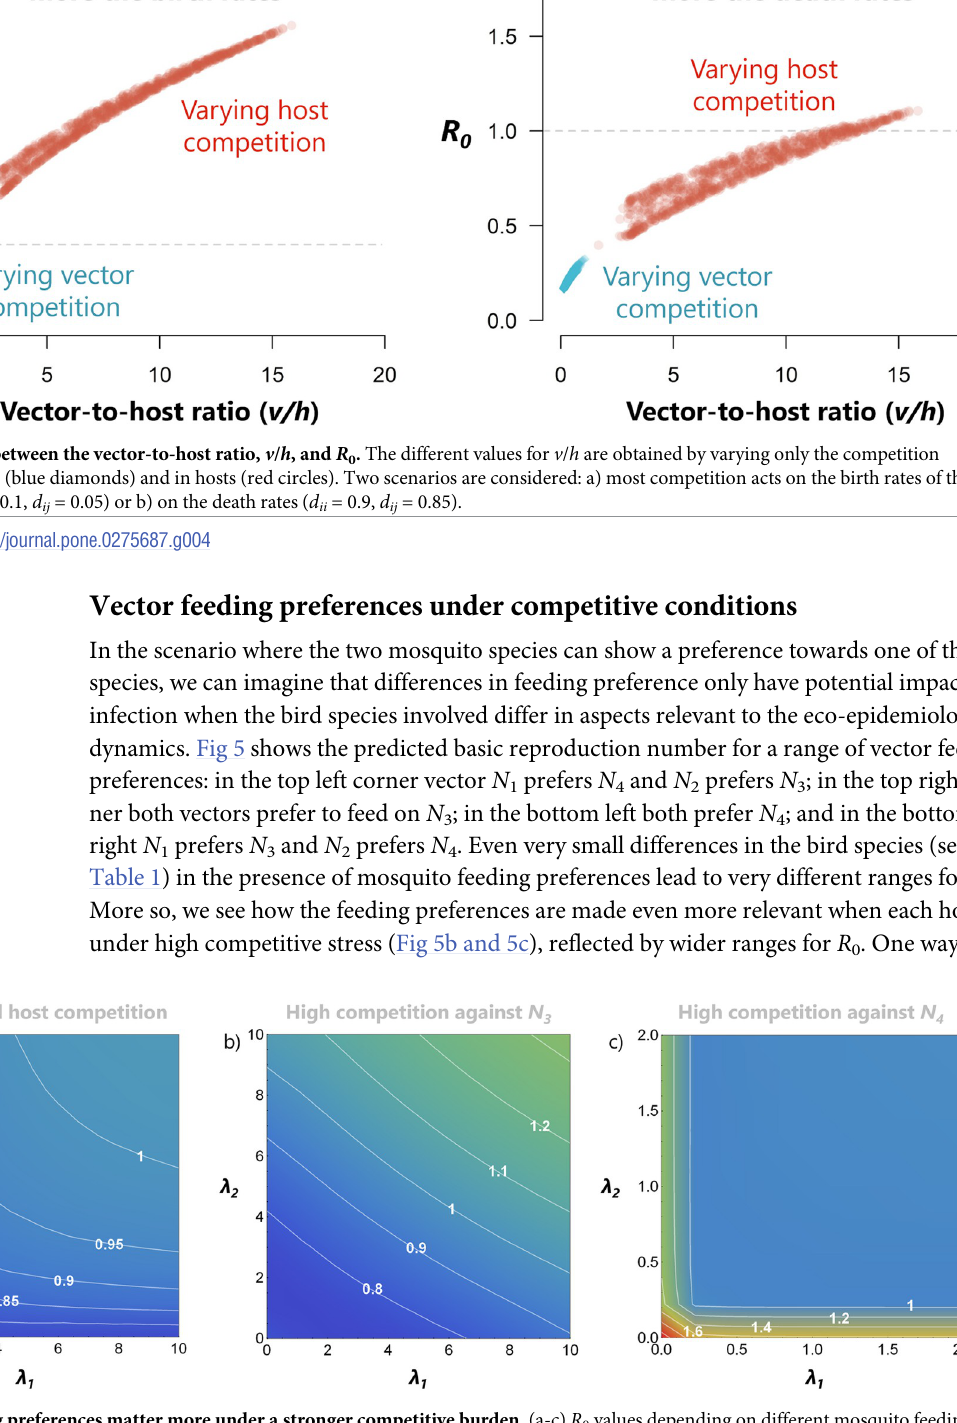
Fig 5. Vector feeding preferences matter more under a stronger competitive burden. (a-c) R 0 values depending on different mosquito feeding preferences, λ 1 and λ 2 , under three scenarios of host competition: a) c 33 = c 44 , c 34 = c 43 ; b) 2 c 33 , 1.5 c 34 ; c) 1.5 c 43 , 2 c 44 (with all other parameters fixed at the values in Table 1).